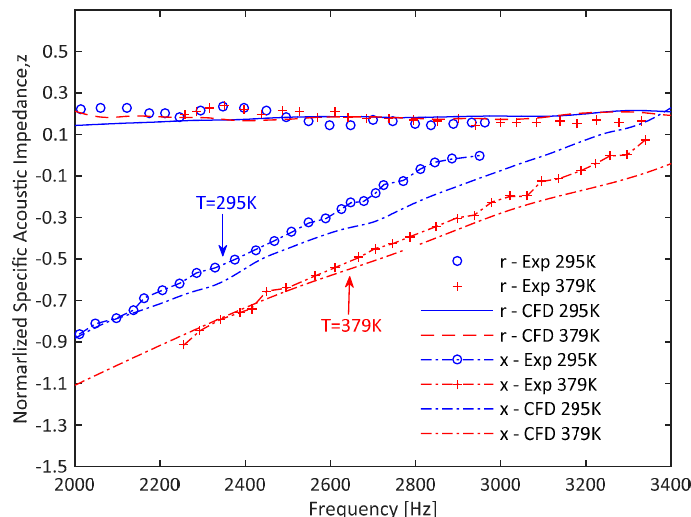
Figure 17. CFD and experimental comparison of normalized specific acoustic impedance (M g = 0.12) [27].